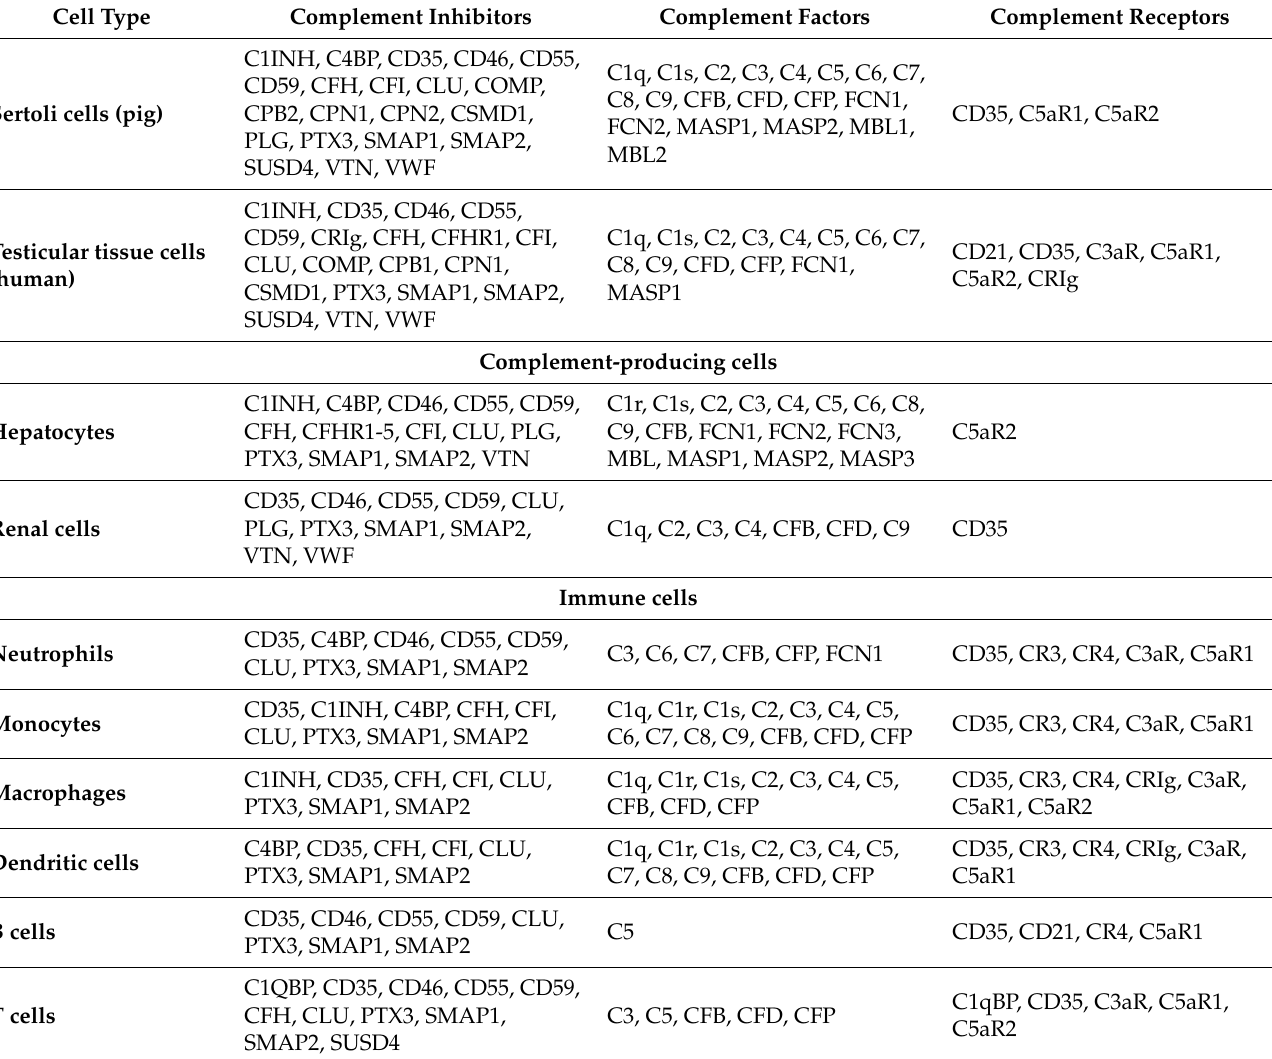
Table 2. Cellular expression of complement inhibitors, factors, and